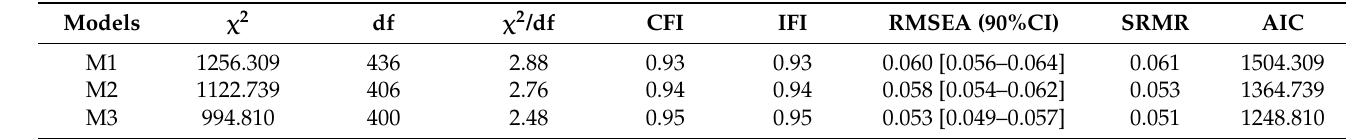
Table 2. Goodness-of-fit indices of